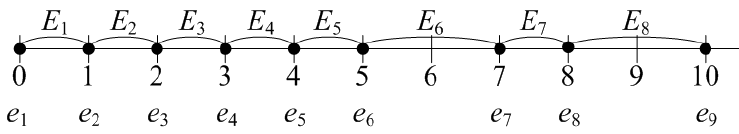
Figure 2. Time intervals of orders’ processing for the trial problem. Results of the method’s execution upon the trial problem are given in Table